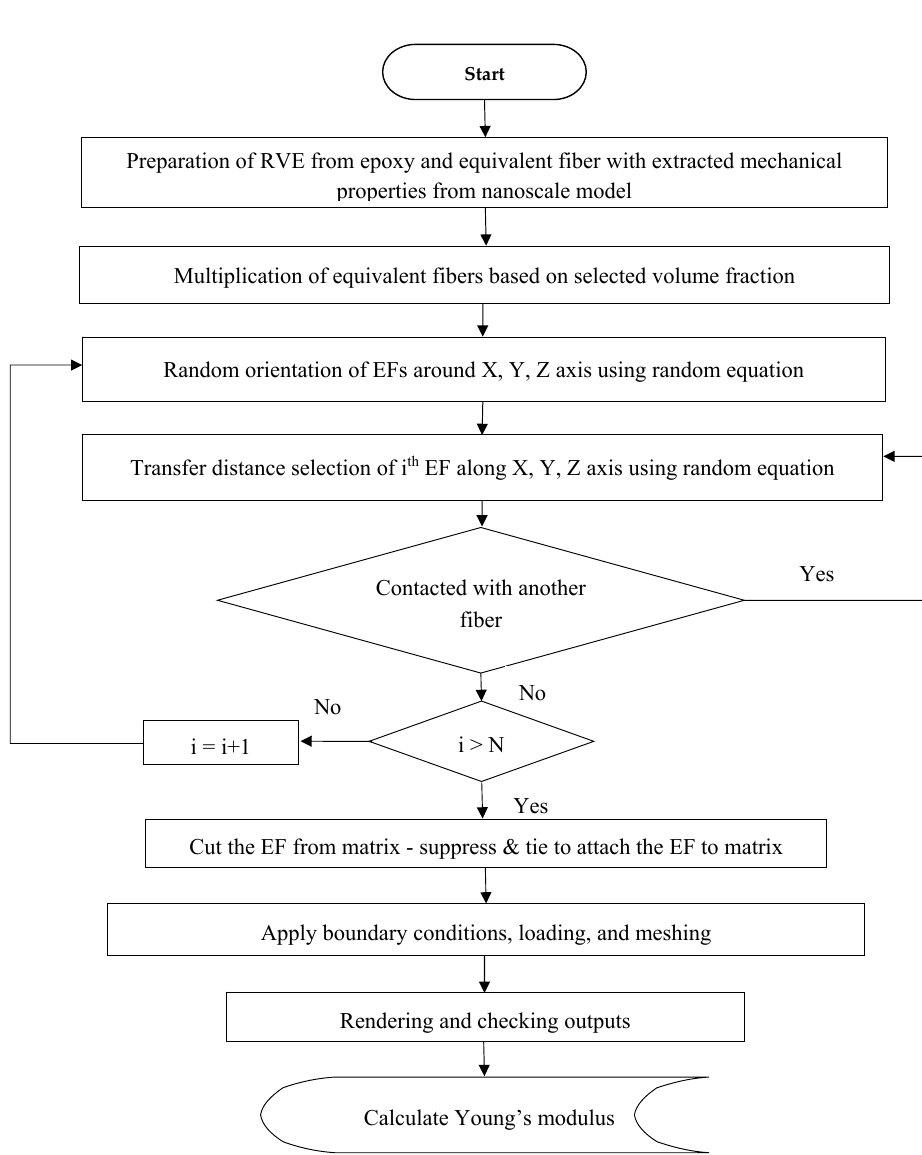
Figure 12. Flowchart of the RVE modeling at the microscale. Nanomaterials 2018 , 8 , x FOR PEER REVIEW